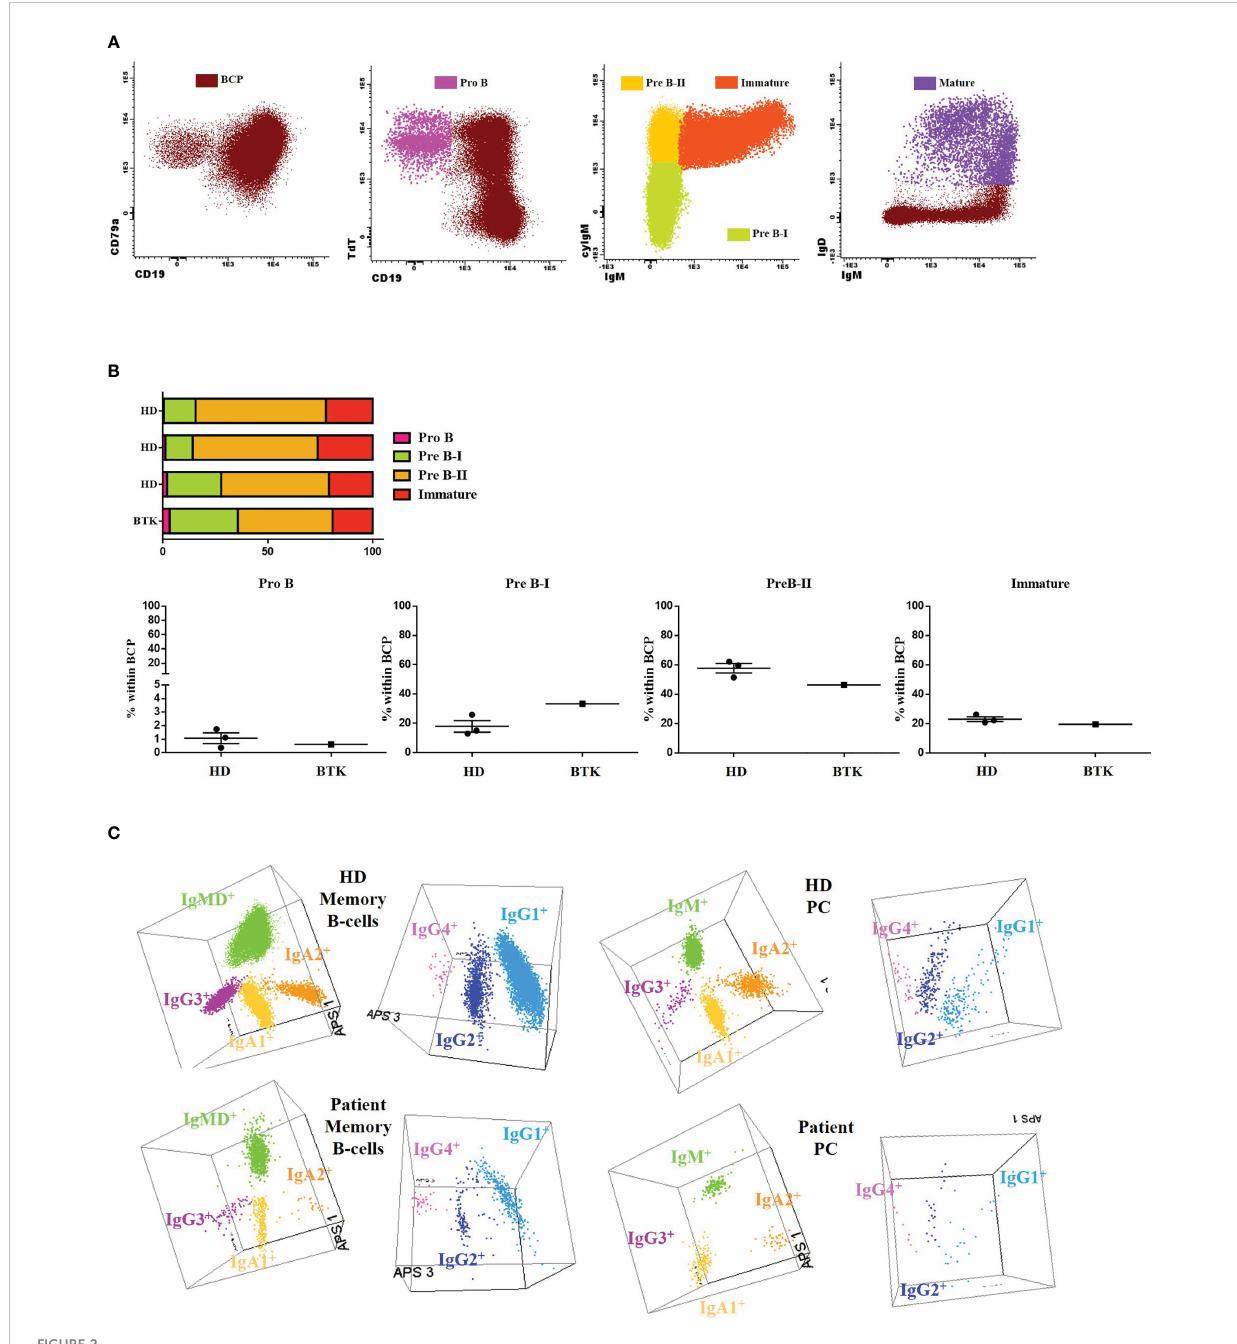
FIGURE 2 B-cell subsets: (A) The results of the IgH isotype and subclasses distribution in memory B cells (MBC) and plasma cells (PC) analyzed by fl ow cytometry in the patient and a representative healthy donor (HD). Representation on a balanced 3-dimension (3D) automated population separator (APS) diagram, constructed using the fi rst three principal components (PC1 to PC3) derived from PC analysis (PCA) performed with the In fi nicyt software. (B) Gating strategy used for classifying B-cell precursors (BCP) (CD79a + ) and then dissecting into different subsets: Pro B (CD19 - TdT + CD34 + ), Pre-B-I (CD19 + cyIgu - IgM - ), Pre-B-II (CD19 + cyIgu + IgM - ), immature (CD19 + cyIgu + IgM + IgD - ) and mature (CD19 + IgM + IgD + ). (C) BCP subset distribution in the patient and 3 age-matched